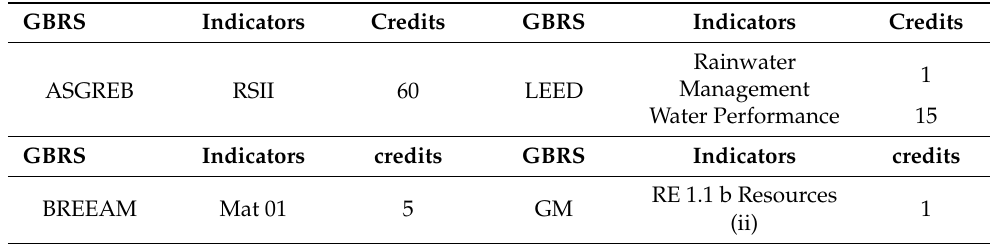
Table 7. Water scope CO 2 -related indicators analysis.